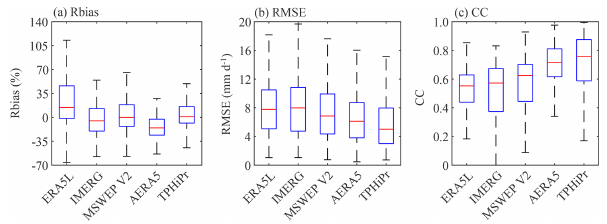
Figure 9. Comparison of (a) Rbias, (b) RMSE and (c) CC for ERA5L, IMERG, MSWEP v2, AERA5 and TPHiPr. The box rep- resents the distribution of the metrics for all 197 independent rain gauges in the